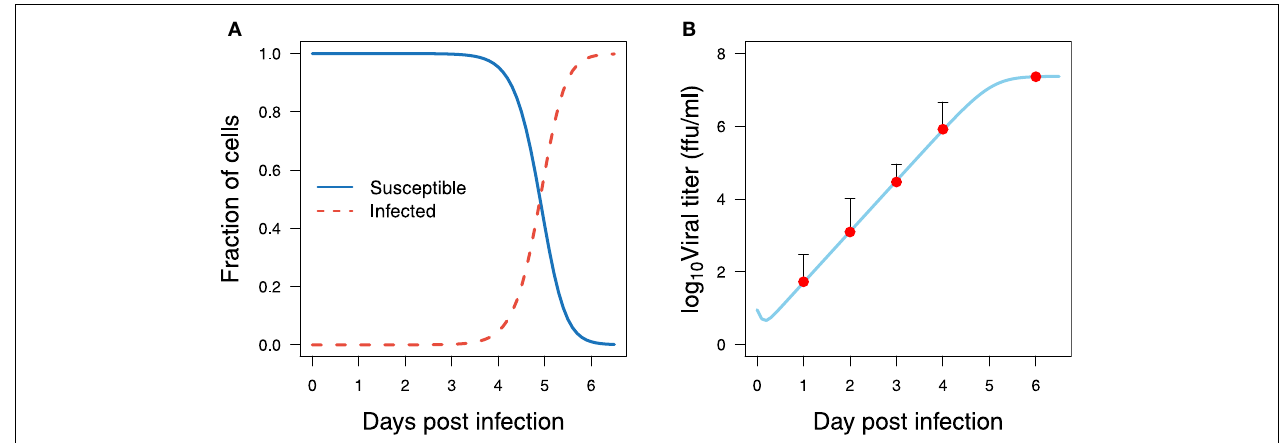
FIGURE 7 | Model fitting for EBOV kinetics. Viral titer data with low MOI from Halfmann et al. (2008) and simulations from the best fit shown in Table 1 are in panel (A) for the host cells and (B) for the viral titer.